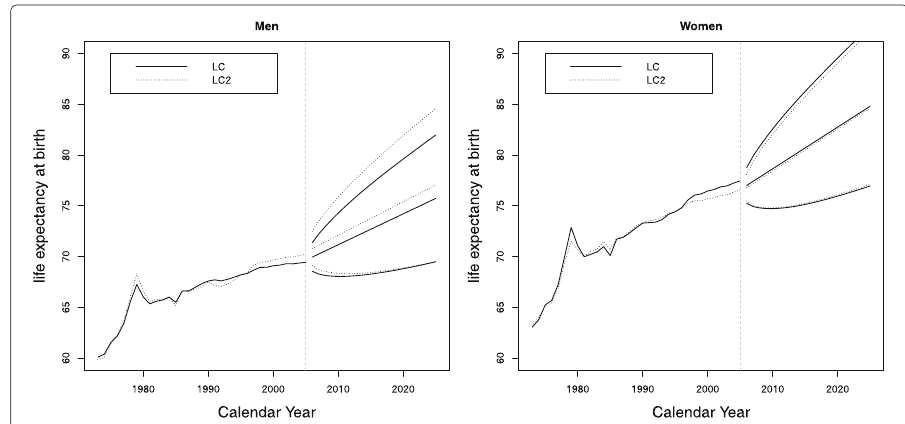
Fig. 10 Evolution for life expectancy between 1973 and 2025, Colombia, men and women